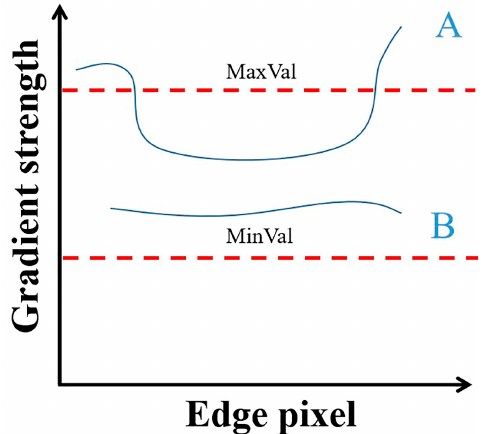
Figure 8. Double-threshold edge-connection processing.